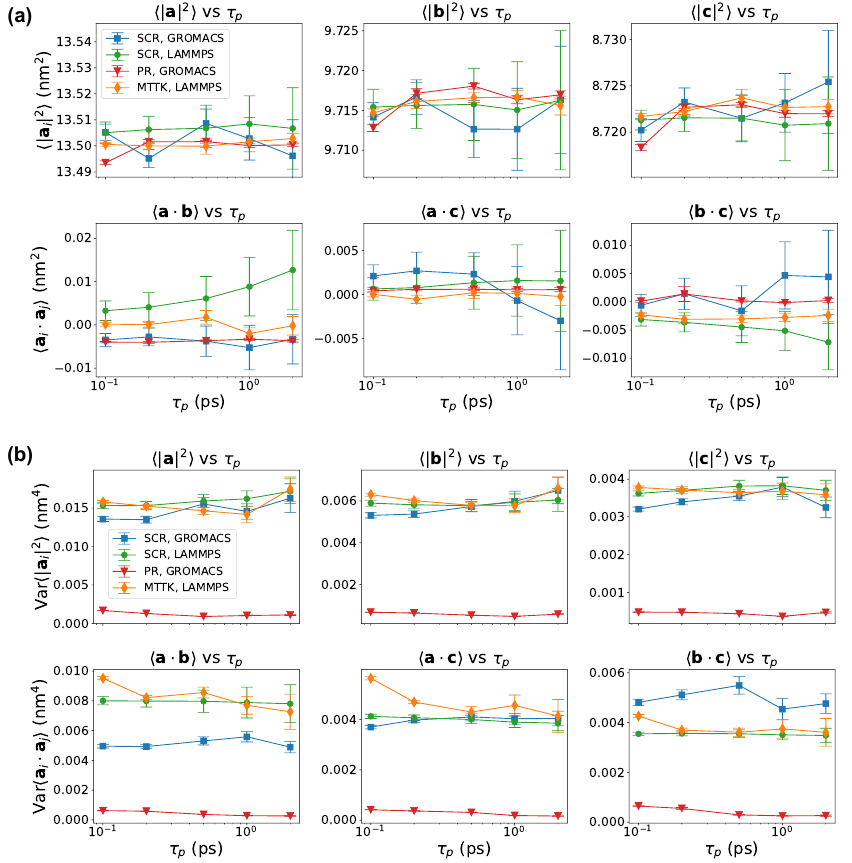
Figure 8. Results for crystal ice I h simulated with GROMACS and LAMMPS. Averages—panels ( a )—and variances—panels ( b )—of pairwise scalar products among the lattice vectors, reported as a function of τ P , for different barostats and codes as